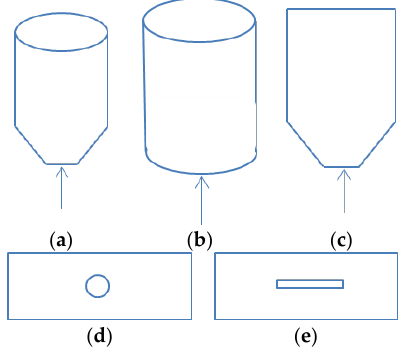
Figure 7. Different geometries applied in SB: conical ( a ); cylindrical ( b ) or prismatic ( c ); Injection of gas through circular cross section ( d ) or rectangular slot ( e ).